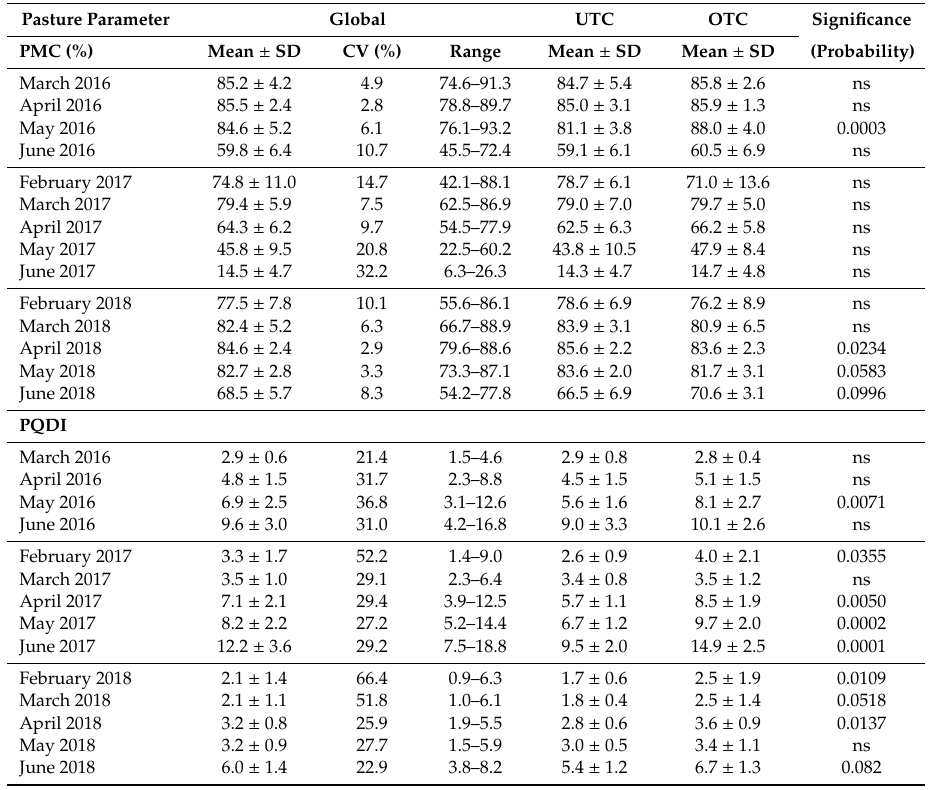
Table 4. Pasture quality (PMC, pasture moisture content, %; and PQDI, pasture quality degradation index, %) of the studied field for each sampling date: Global (all sampling points), UTC (12 sampling points under tree canopy) and OTC (12 sampling points outside tree canopy). Pasture Parameter